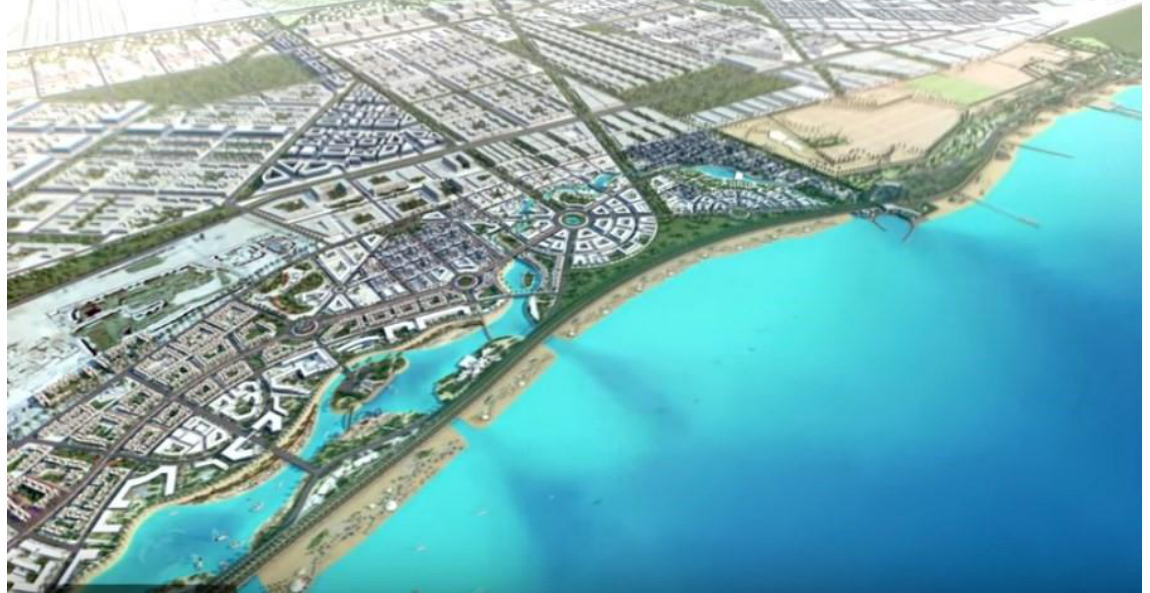
Figure 1: Aerial view of The New Alamein City